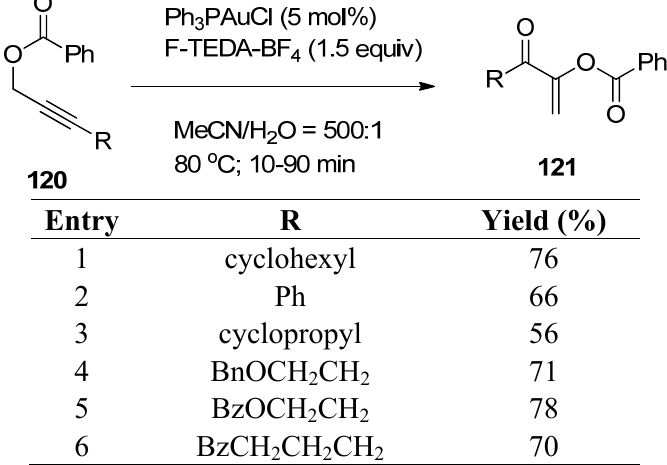
Table 11. Gold-catalyzed synthesis of 1-benzoylvinyl ketones from